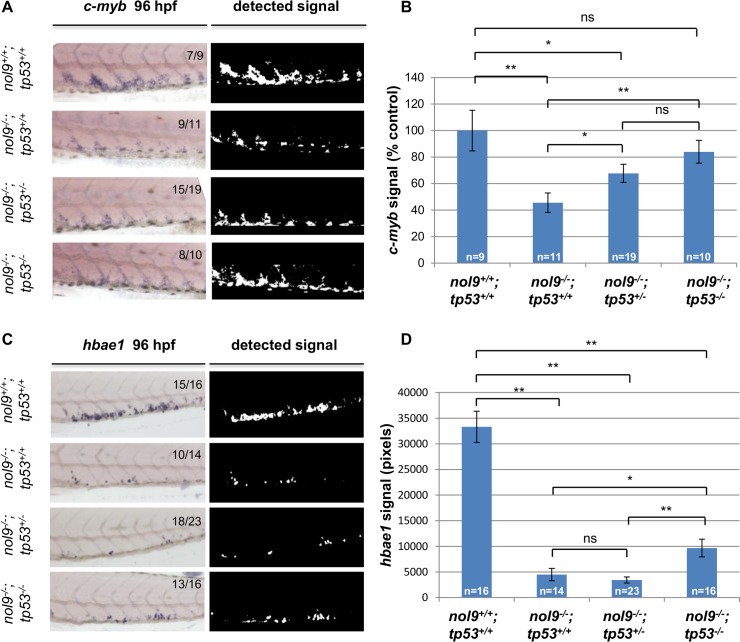
The number of HSPCs is rescued in a tp53 mutant background.(A) The CHT of 96 hpf larvae from a nol9
+/sa1022
;tp53
+/zdf1 x nol9
+/sa1022
;tp53
+/zdf1 cross stained by WISH against c-myb. Signal extracted from the corresponding WISH photograph is shown. Numbers represent larvae with the displayed phenotype out of the total number of larvae examined. (B) Quantification of c-myb in situ signal for 96 hpf larvae from a nol9
+/sa1022
;tp53
+/zdf1 x nol9
+/sa1022
;tp53
+/zdf1 cross, depending on their genotype. Data are represented as the mean number of pixels +/- SEM. nol9
+/+
;tp53
+/+ n = 9; nol9
-/-
;tp53
+/+ n = 11; nol9
-/-
;tp53
+/zdf1 n = 19; nol9
-/-
; tp53
zdf1/zdf1 n = 10. Two-tailed Student’s t-Test, *, p<0.05; **, p<0.01. (C) Representative pictures of the CHT of 96 hpf larvae from a nol9
+/sa1022
;tp53
+/zdf1 x nol9
+/sa1022
;tp53
+/zdf1 cross stained by WISH against hbae1. Signal extracted from the corresponding WISH photograph is shown. (D) Quantification of hbae1 WISH signal for larvae from a nol9
+/sa1022
;tp53
+/zdf1 x nol9
+/sa1022
;tp53
+/zdf1 cross, depending on their genotype. Data are represented as the mean number of pixels +/- SEM. nol9
+/+
;tp53
+/+ n = 16; nol9
-/-
;tp53
+/+ n = 14; nol9
-/-
;tp53
+/- n = 23; nol9
-/-
;tp53
-/- n = 16. Two-tailed Student’s t-Test, *, p<0.05; **, p<0.01. Within the figure, nol9
sa1022 allele has been denoted as nol9
- and tp53
zdf1 as tp53
-.